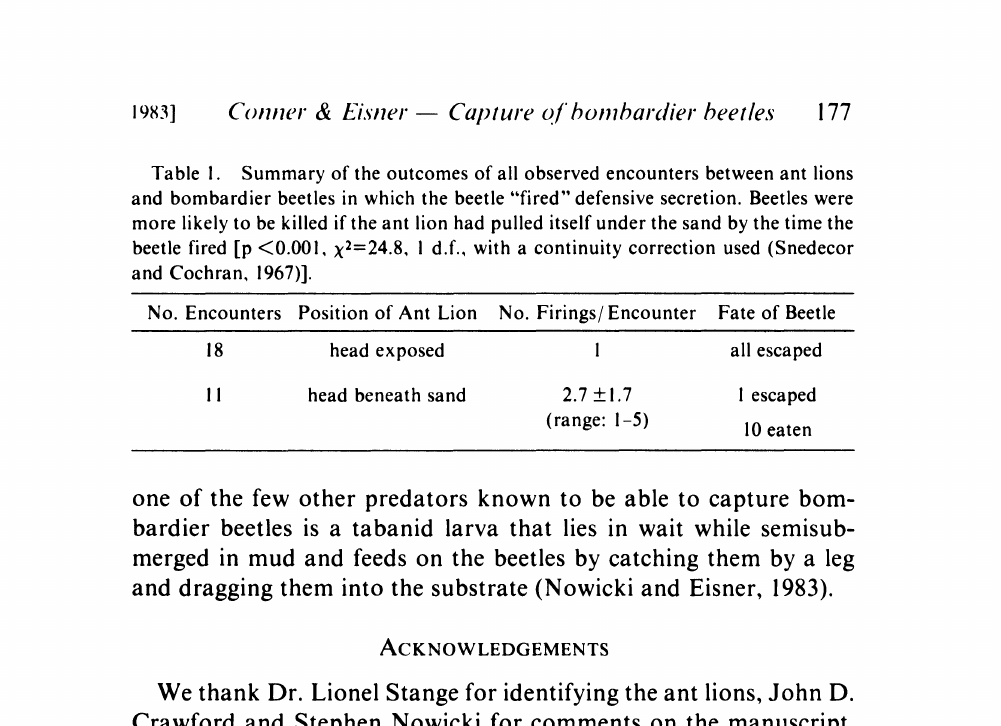
Table 1. Summary of the outcomes of all observed encounters between ant lions and bombardier beetles in which the beetle "fired" defensive secretion. Beetles were more likely to be killed if the ant lion had pulled itself under the sand by the time the beetle fired [p <0.001, X2=24.8, d.f., with a continuity correction used (Snedecor and Cochran,